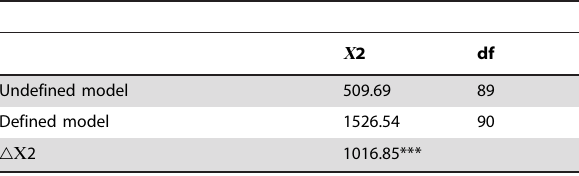
Table 6. Discriminant Validity for 15-item GIS-family